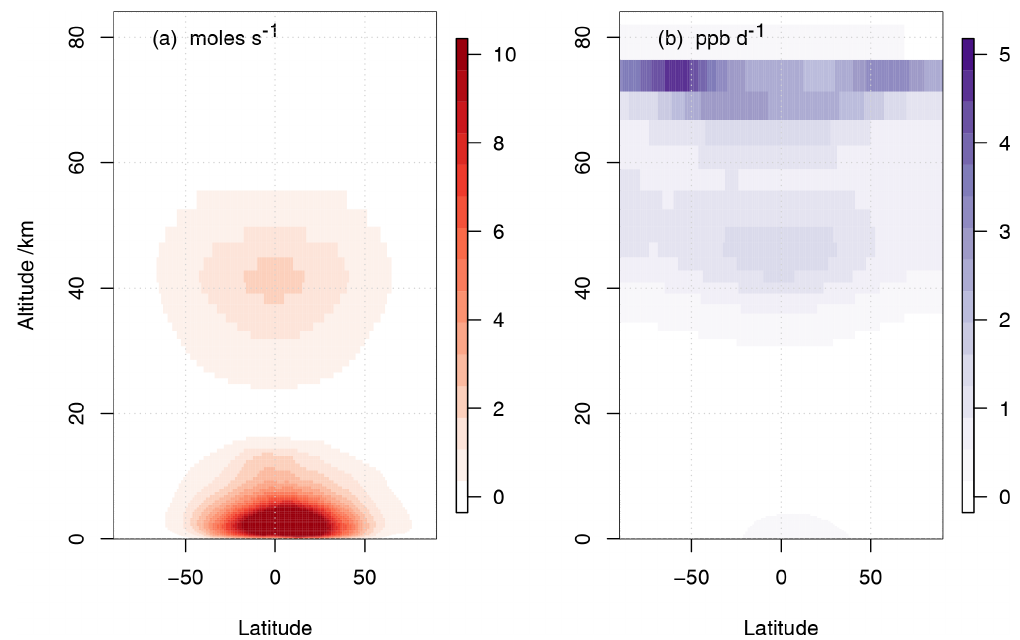
Figure 3. Multi-annual mean zonal-mean production of H 2 O from the UKCA StratTrop mechanism in UKESM1. Panel (a) shows the production in moles per second and panel (b) in parts per billion per day, highlighting the larger relative source of water from chemical processes in the upper